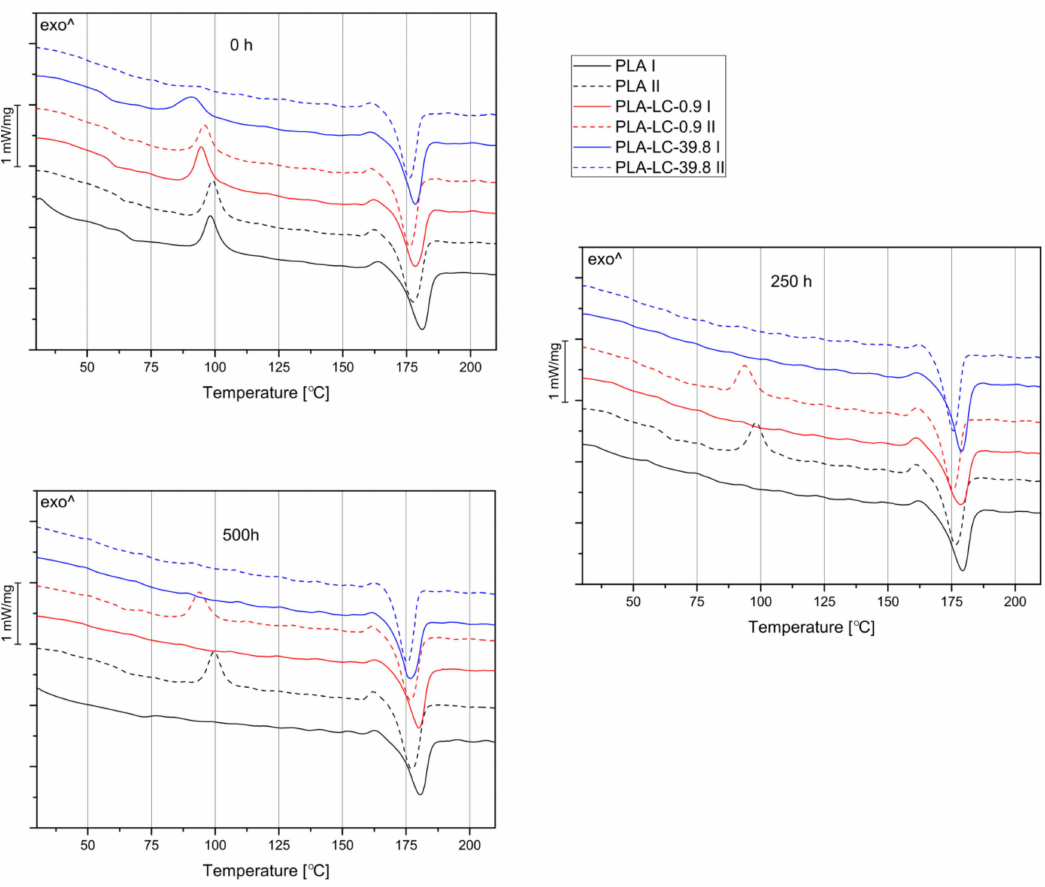
Figure 5. Di ff erential scanning calorimetry (DSC) curves obtained during the first (I) and second heating (II) of selected samples weathered for 0, 250, and 500